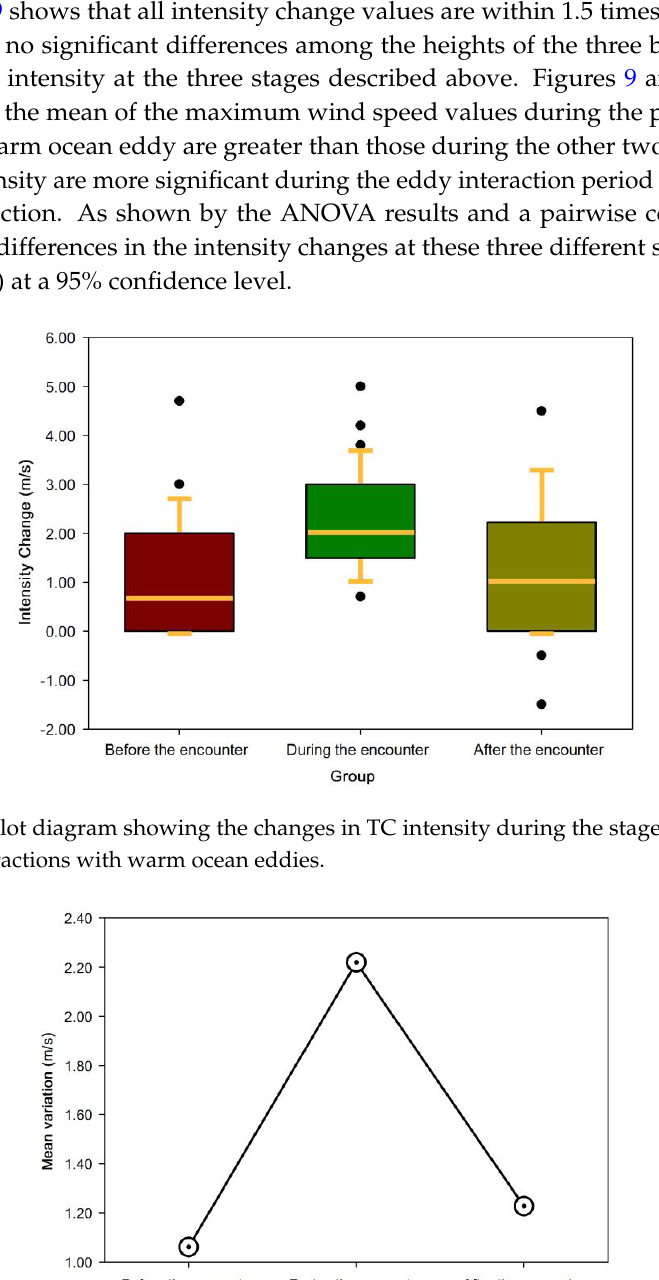
Figure 10. The mean value of the changes of TC intensity within a 6-h span before, during, and after interactions between TCs and warm ocean eddies. Table 7. The differences in maximum wind speed changes within a 6-h span before, during, and after interactions between TCs and warm ocean eddies.